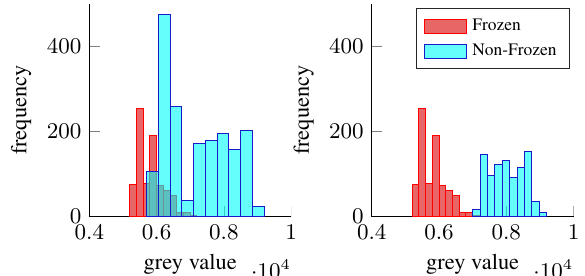
Figure 9: Statistics of the clean cloud-free pixels in MODIS emissive channel B 22 for lake Sihl from winter 2016 - 17 . Left and right columns show the statistics with pixels from December 2016 included and excluded